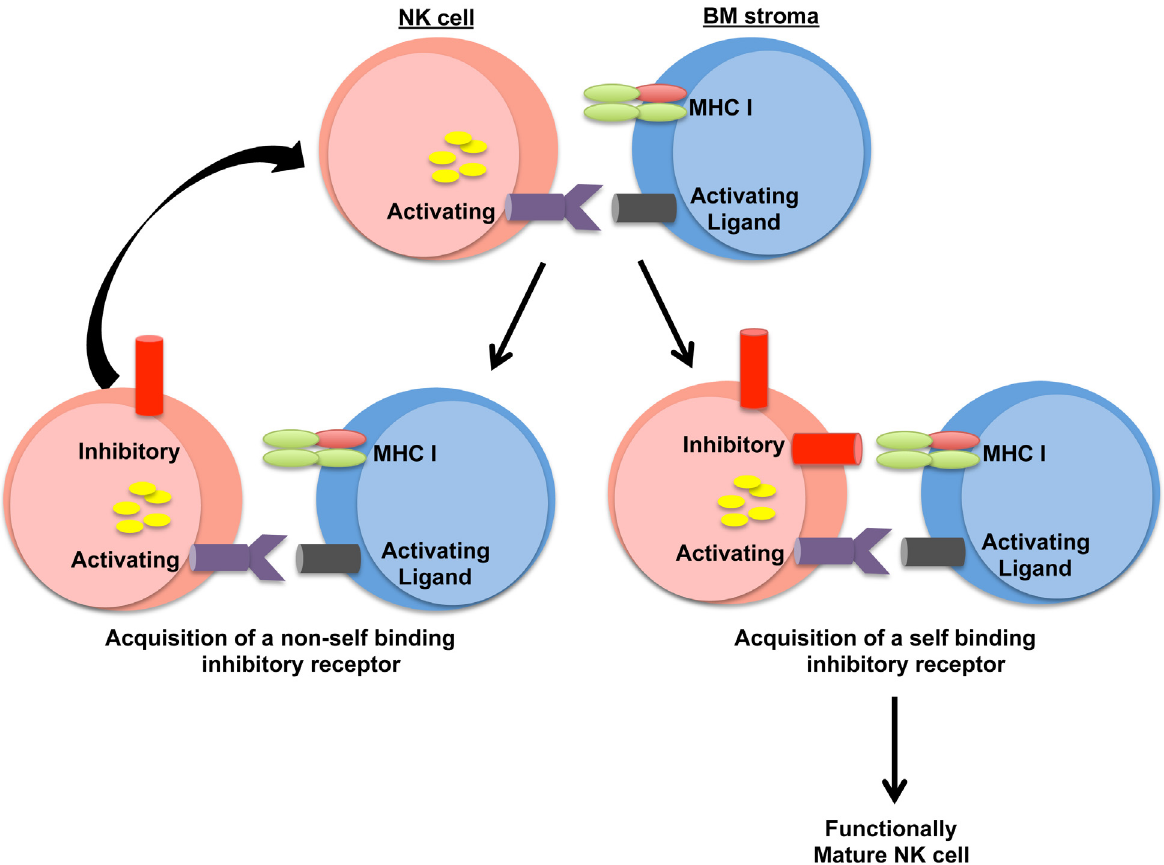
Fig 6. Activating receptor-mediated signaling is the driving force for Ly49 receptor induction during NK cell development. Activating receptors on developing NK cells are stimulated by their respective ligands via interactions with BM stromal cells. This interaction results in the activation of transcription factors that promote Ly49 receptor expression. If the Ly49 receptor that is acquired does not recognize self-MHC I, the NK cell continues to receive “ positive ” activating receptor signals, which increases the probability of the NK cell to acquire another Ly49 receptor. This process occurs until a self-MHC I binding Ly49 is acquired, which will dampen the activating receptor signal. This NK cell can then mature and migrate to peripheral tissues to perform “ missing-self ”